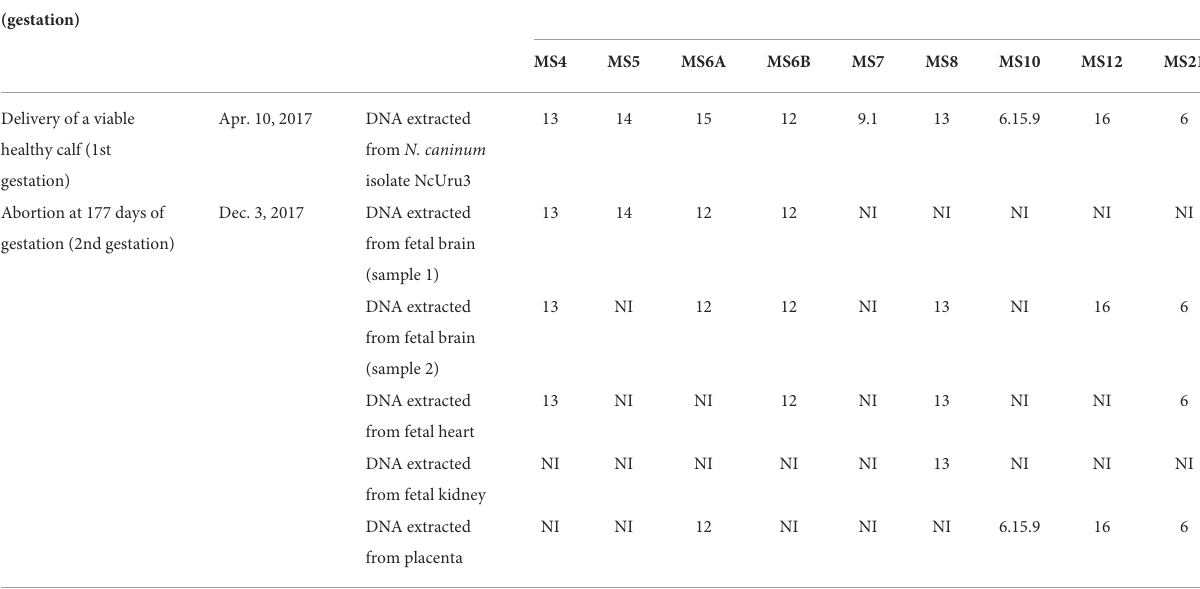
TABLE 1 Pregnancy outcome, dates and results of microsatellite typing in two strains/genotypes of N. caninum infecting the offspring of the Holstein dam. Pregnancy